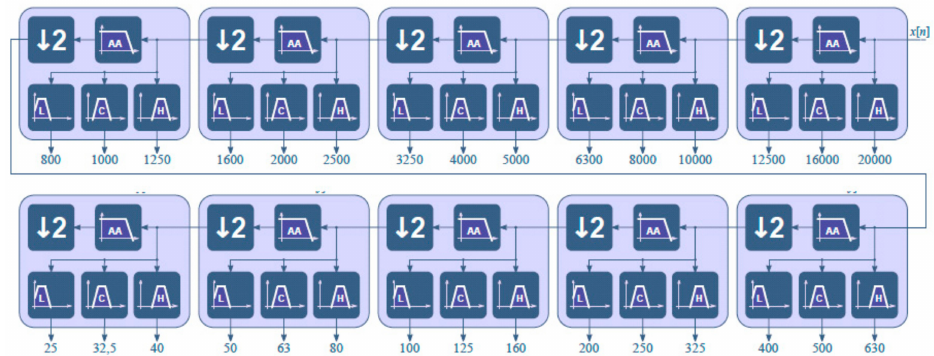
Figure 7. Filter bank for the one-third octave. The frequencies are shown in Hz.